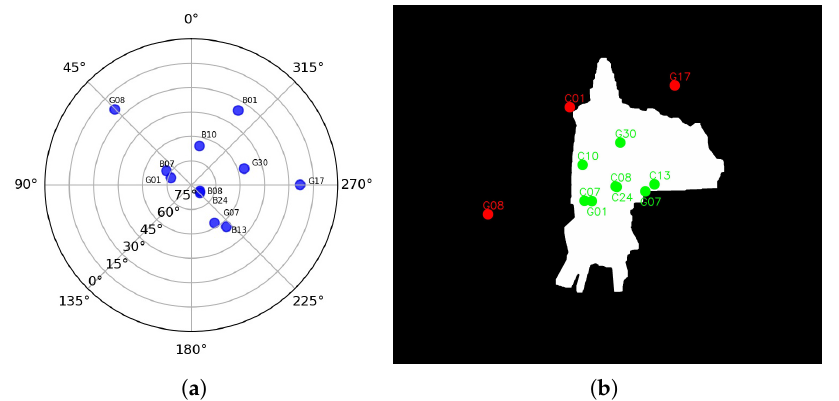
Figure 14. Results of NLOS signal rejection. ( a ) The satellite skyplot. ( b ) NLOS signal rejection results. Green circles represent LOS satellites, and red circles represent NLOS satellites.